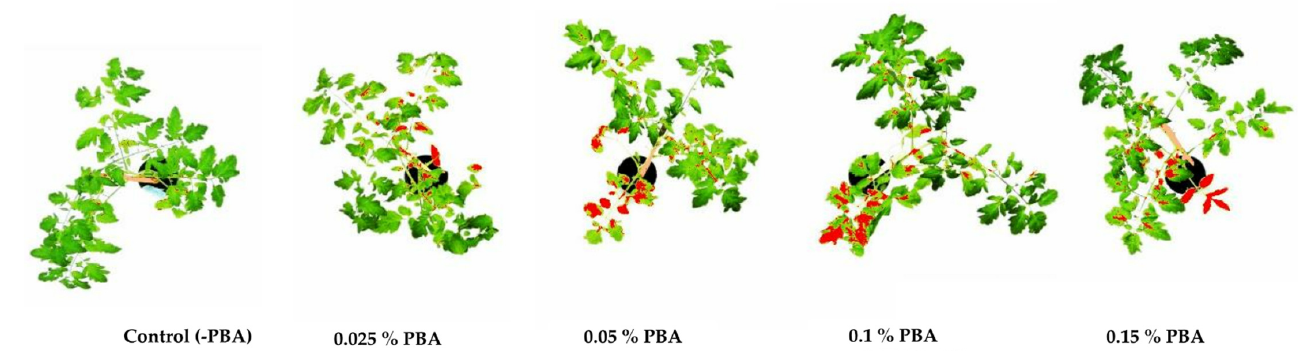
Figure 2. Total physiological lesion area on tomato plants 14 days after PBA application, measured by software ImageJ.